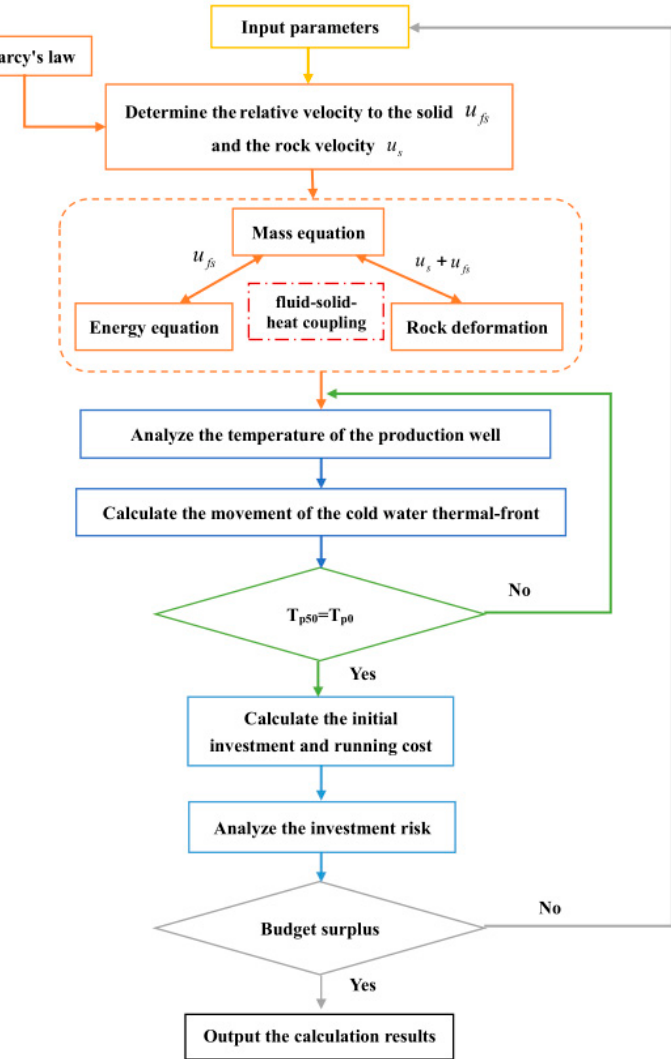
Figure 5. Flowchart of simulation procedure.